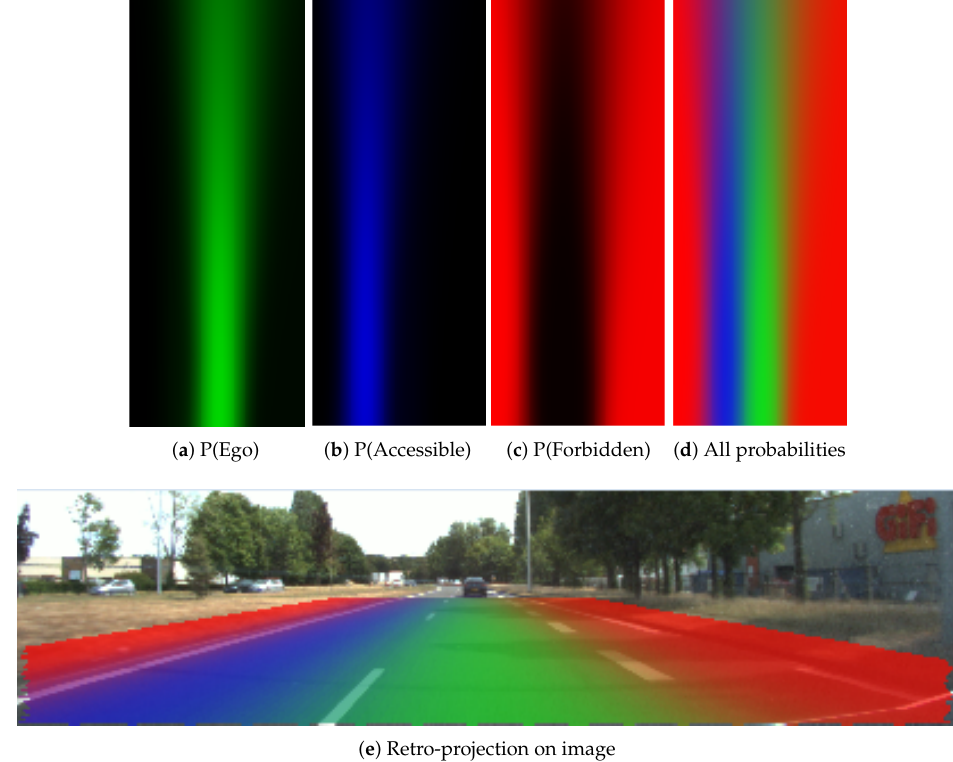
Figure 13. Probabilistic grids with large uncertainty ( σ x = 0.9 m, σ y = 1.1 m, σ θ = 0.1 radians )